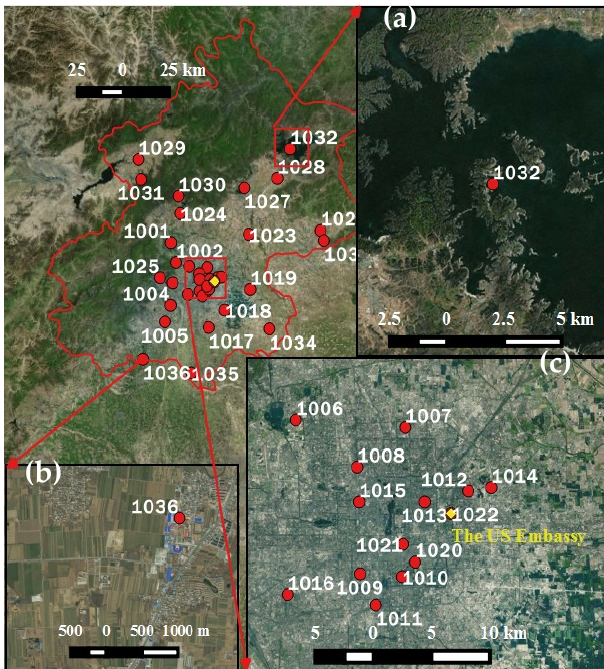
Figure 12. Distribution of monitoring stations (labels are IDs) overlaid on a satellite map. Three areas are enlarged to show the conditions of the corresponding land surface. ( a ) The lowest average observation was in station 32; ( b ) The highest one was in station 36; ( c ) The central area is also enlarged to show the locations of stations and the US Embassy, which is marked in yellow.